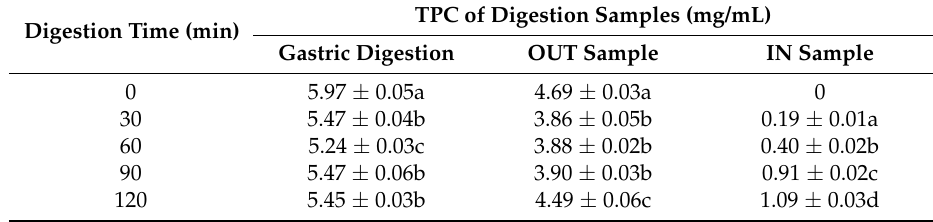
Figure 1. Representative normal-phase HPLC/VWD chromatograms of samples from A. mearnsii bark at different time points during the simulated gastric-intestinal digestion, ( A ) gastric digestion; ( B ) intestinal digestion. The OUT samples represent the solution outside the tubing. Table 1. Total polyphenol content (TPC) of samples from A. mearnsii bark at different time points during the simulated gastric-intestinal